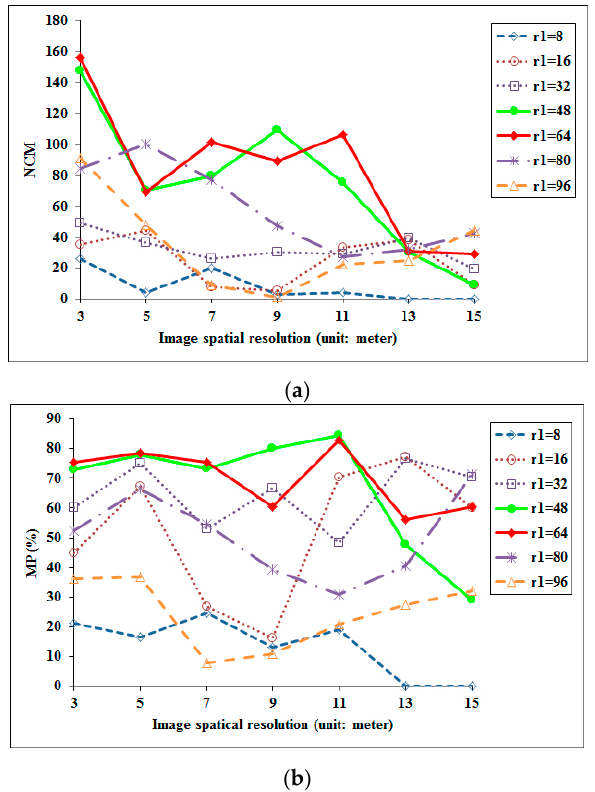
Figure 8. Experimental results of feature local support region radius tuning. ( a ) The test results of the criteria NCM for image pairs with different spatial resolution. Where r 1 (unit: pixel) is the local support region radius of the features in the image with resolution λ 1 . The local support region radius of those features in another image with resolution λ 2 is computed as r 1 · λ 1 / λ 2 . ( b ) The test results of the criteria MP for image pairs with different spatial resolution.